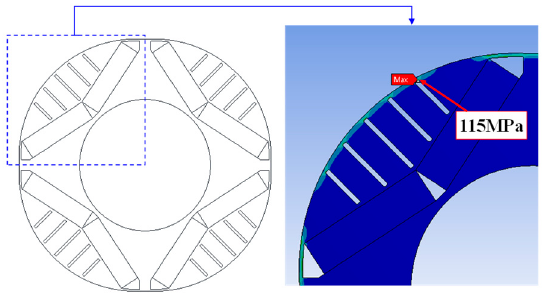
Figure 17. Maximum mechanical stress of the final rotor design.